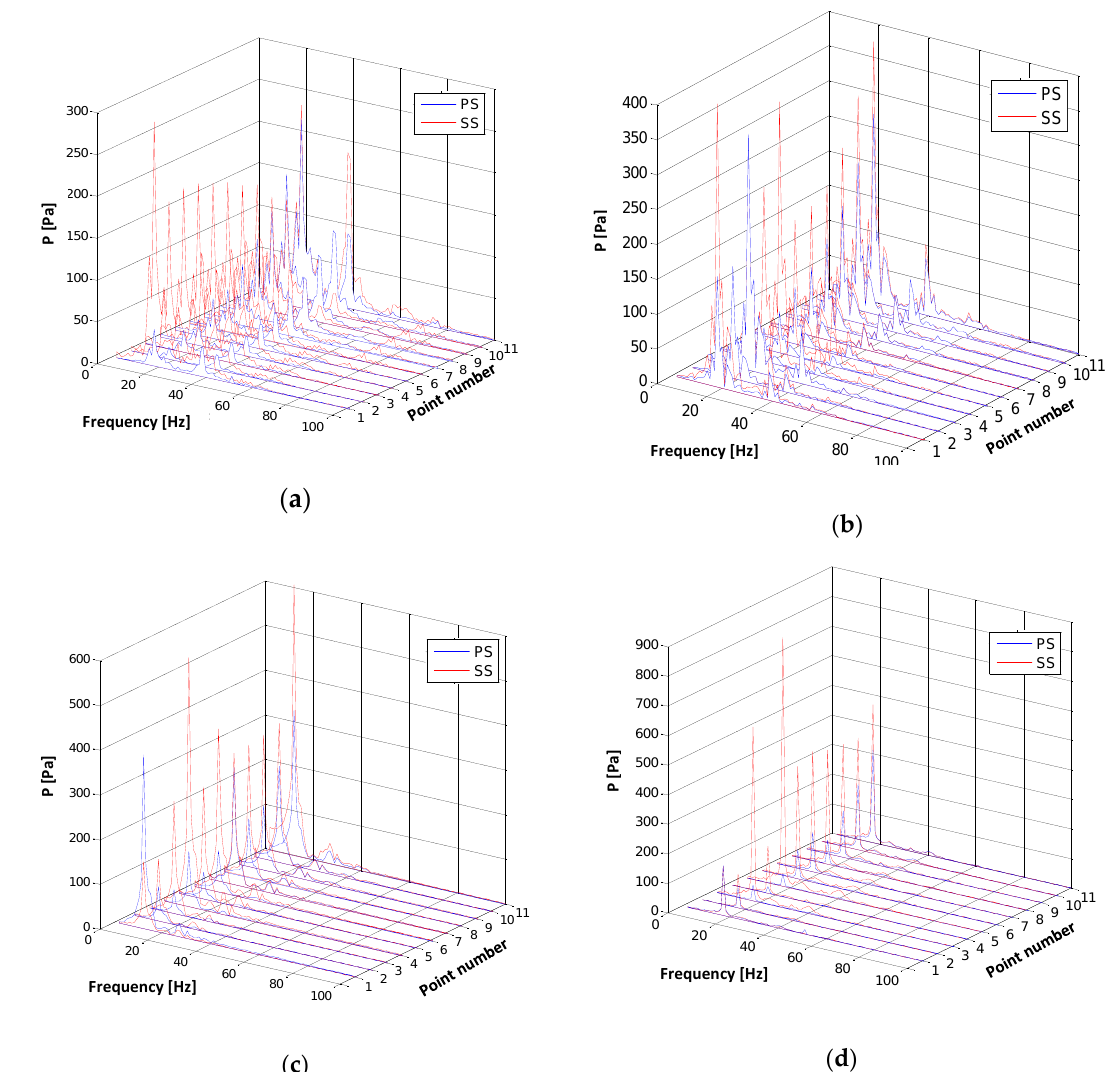
Figure 13. Frequency diagram for different TCSs. ( a ) δ = 0%; ( b ) δ = 0.25%; ( c ) δ = 0.5%; ( d ) δ = 0.75%. Table 3. Maximal pressure fluctuation magnitude and dominant frequency for various TCSs.